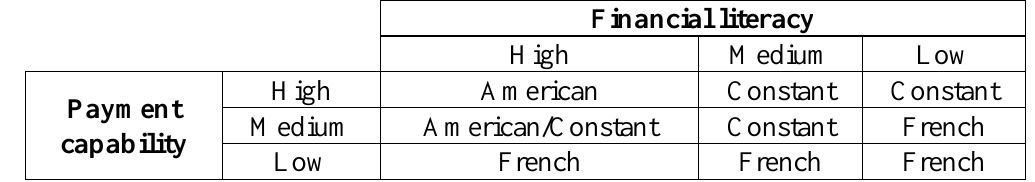
Table 7 . Customer profiles considering the three main repayment plans (American, constant principal repaid and